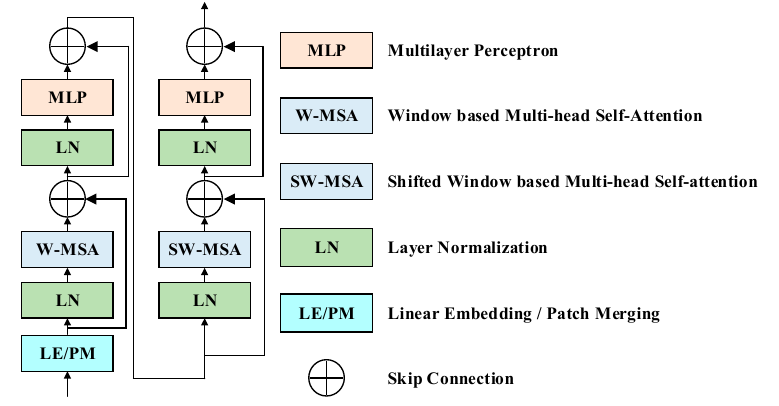
Figure 1. Illustration of Swin Transformer Block.